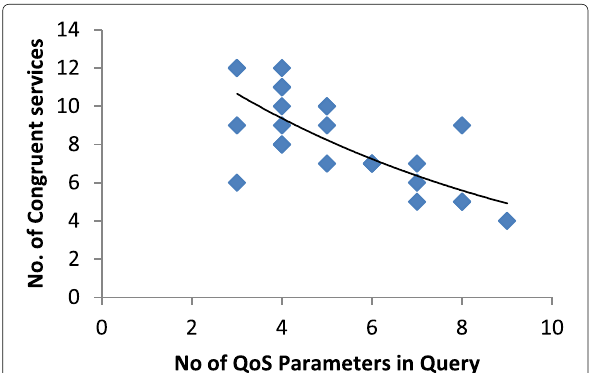
Fig. 2 Number of QoSs vs. Number of congruent